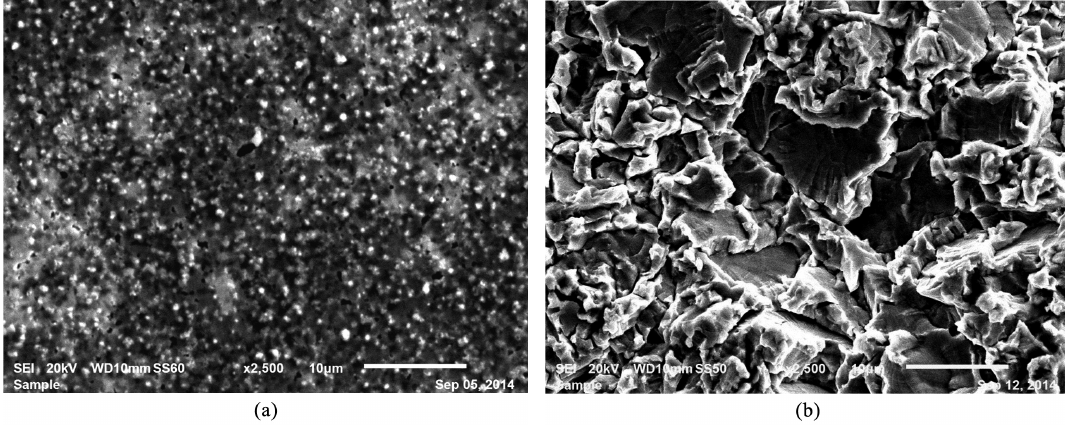
Figure 9. SEM images of the cavitation eroded nitrided surface at: (a) 180 min; and (b) 960 min testing Table 2. Cumulative mass loss (CML) and the average erosion rate (AER) values as a function of the cavitation erosion testing time for non-nitrided and nitrided niobium samples. Parameter Nb condition